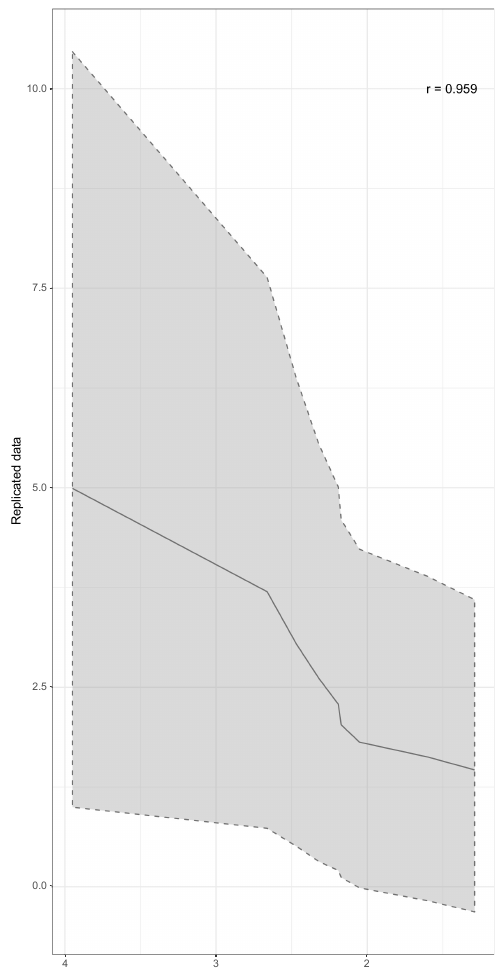
Figure 3. 95% Confidence region of the replicated data. The solid line represents the mean of the replicated data and r is the correlation coefficient of the mean and observed lower record values.